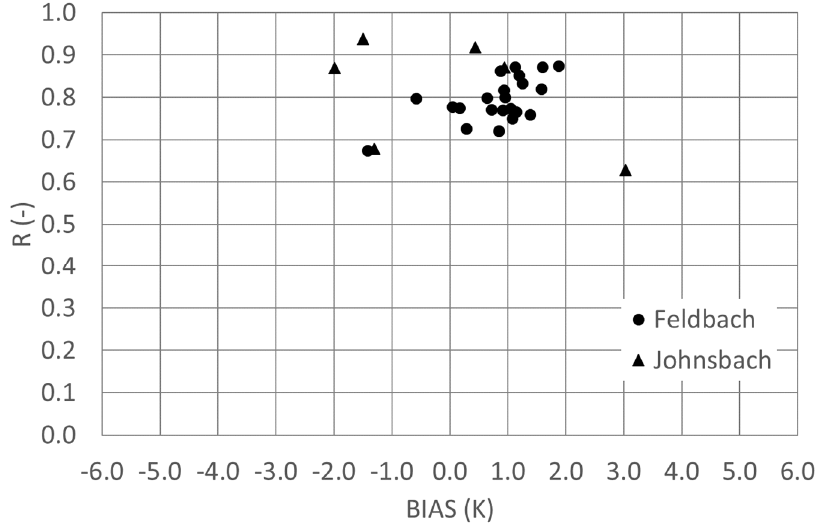
Figure 6. BIAS and correlation coefficient R of modelled air temperatures in the Feldbach and Johnsbach valley domains.